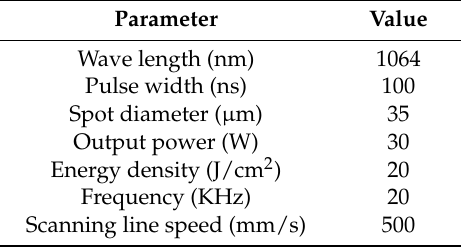
Table 1. Laser system parameters.